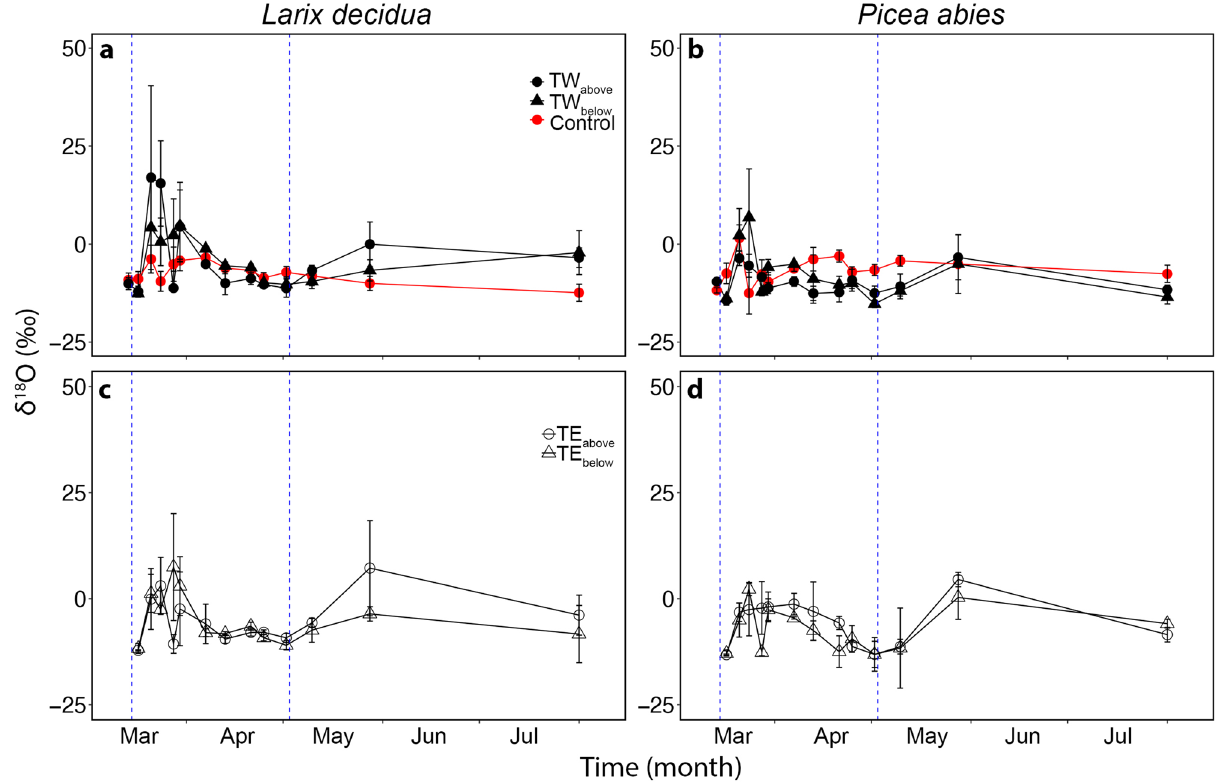
Figure 4. Microcores δ 18 O analyses. δ 18 O analyses (‰) of microcores extracted from the trunk of three L. decidua and three P. abies specimens growing at the alpine treeline during the seasonal course (from 14.03.2017 to 01.08.2017). Panels ( a ) and ( b ) show values from unlabeled specimens (red symbols; breast height and west exposed) and cores collected from the west side of the trunk, 20 cm above (TW above ; full dots) and below (TW below ; full triangles) the labelled branch (see Fig. 1a for sample nomenclature). Panels ( c ) and ( d ) show values from cores collected from the east side of the trunk, 20 cm above (TE above ; open dots) and below (TE below ; open triangles) the labelled branch (see Fig. 1a for sample nomenclature). Mean ± SE. Blue dashed vertical lines indicate the time of bag installation (14.03.2017) and removal